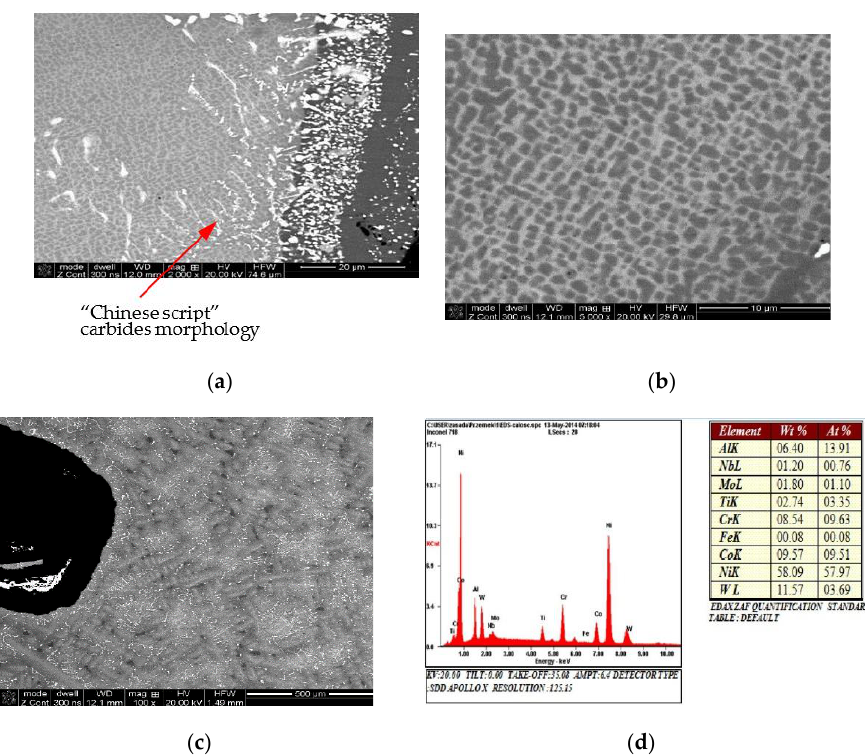
Figure 14. View of the structure of the LPT blade with the barrier coating ( a ), characteristic grain of the cuboidal phase γ ’ ( b ), and uniformly distributed reinforcing precipitations of carbides ( c ). The result of the microanalysis of the chemical composition of the core material ( d ).